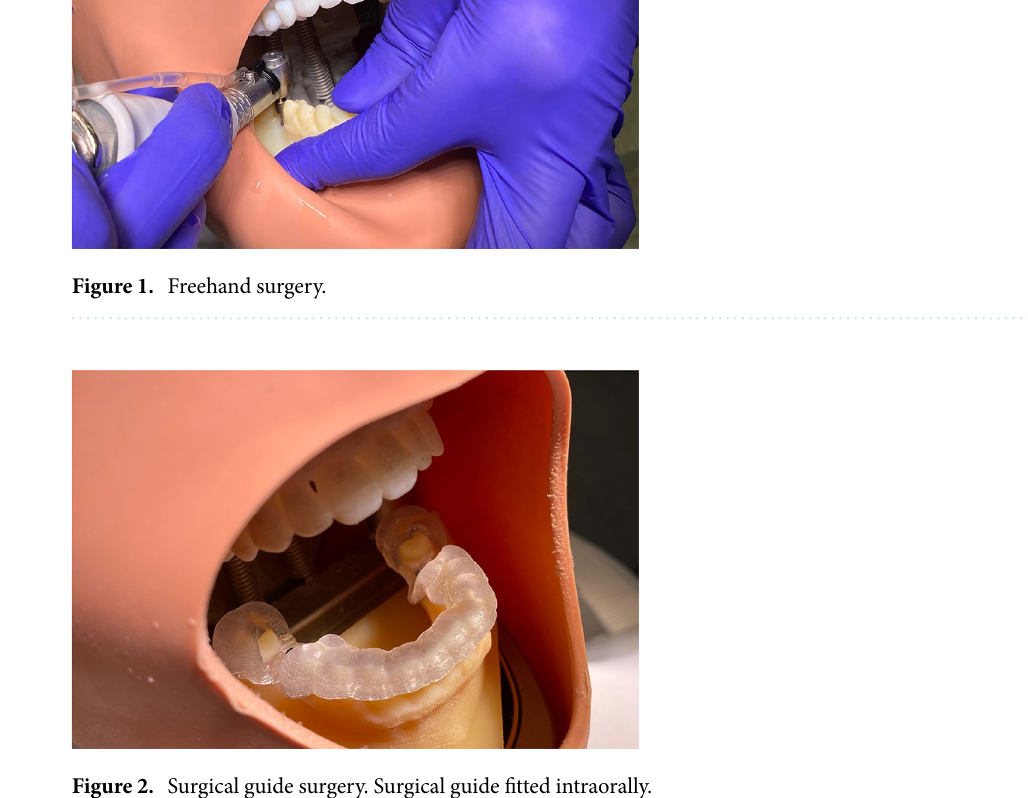
Figure 2. Surgical guide surgery. Surgical guide fitted